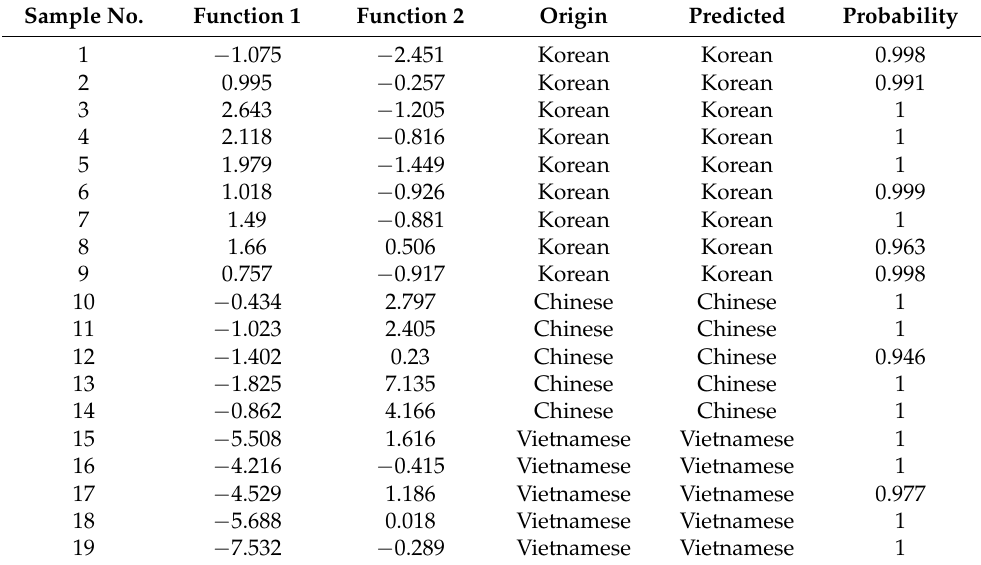
Table 7. Classification of the geographical origins of the blind samples using the established canonical discriminant